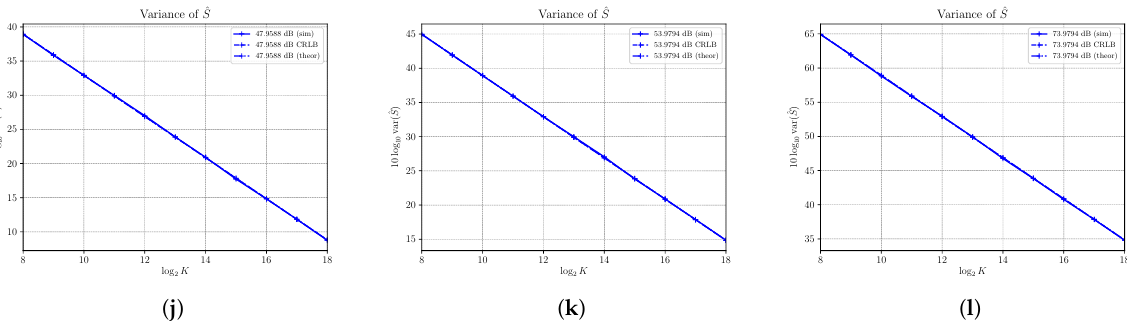
Figure 4. Asymptotic and estimated variances of the signal power estimator ˆ S versus the number of observations K . Each sub figure ( a – l ) shows results for a given nominal value of SNR obtained by changing the signal power S and with noise power N = 4.